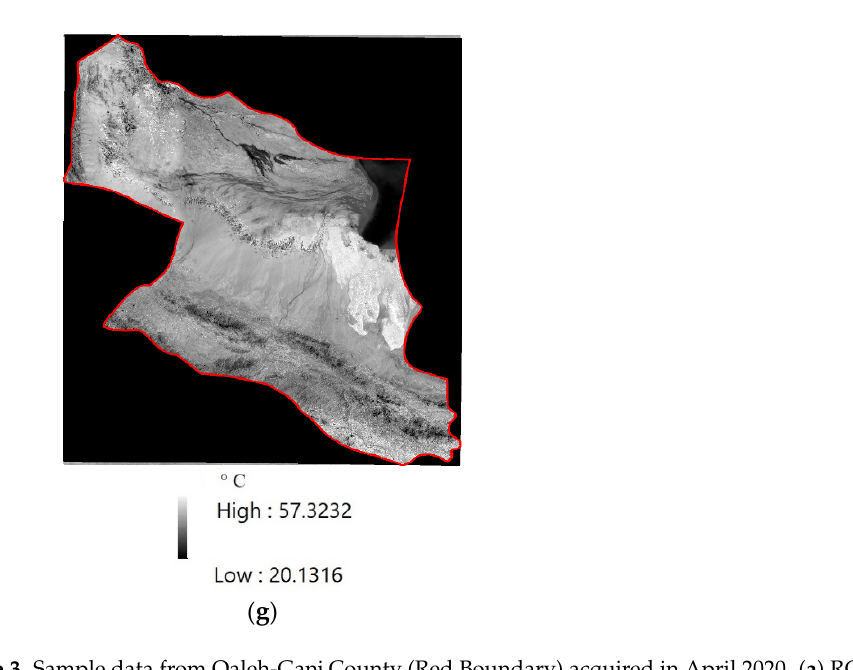
Table 2. Emissivity values based on NDVI.